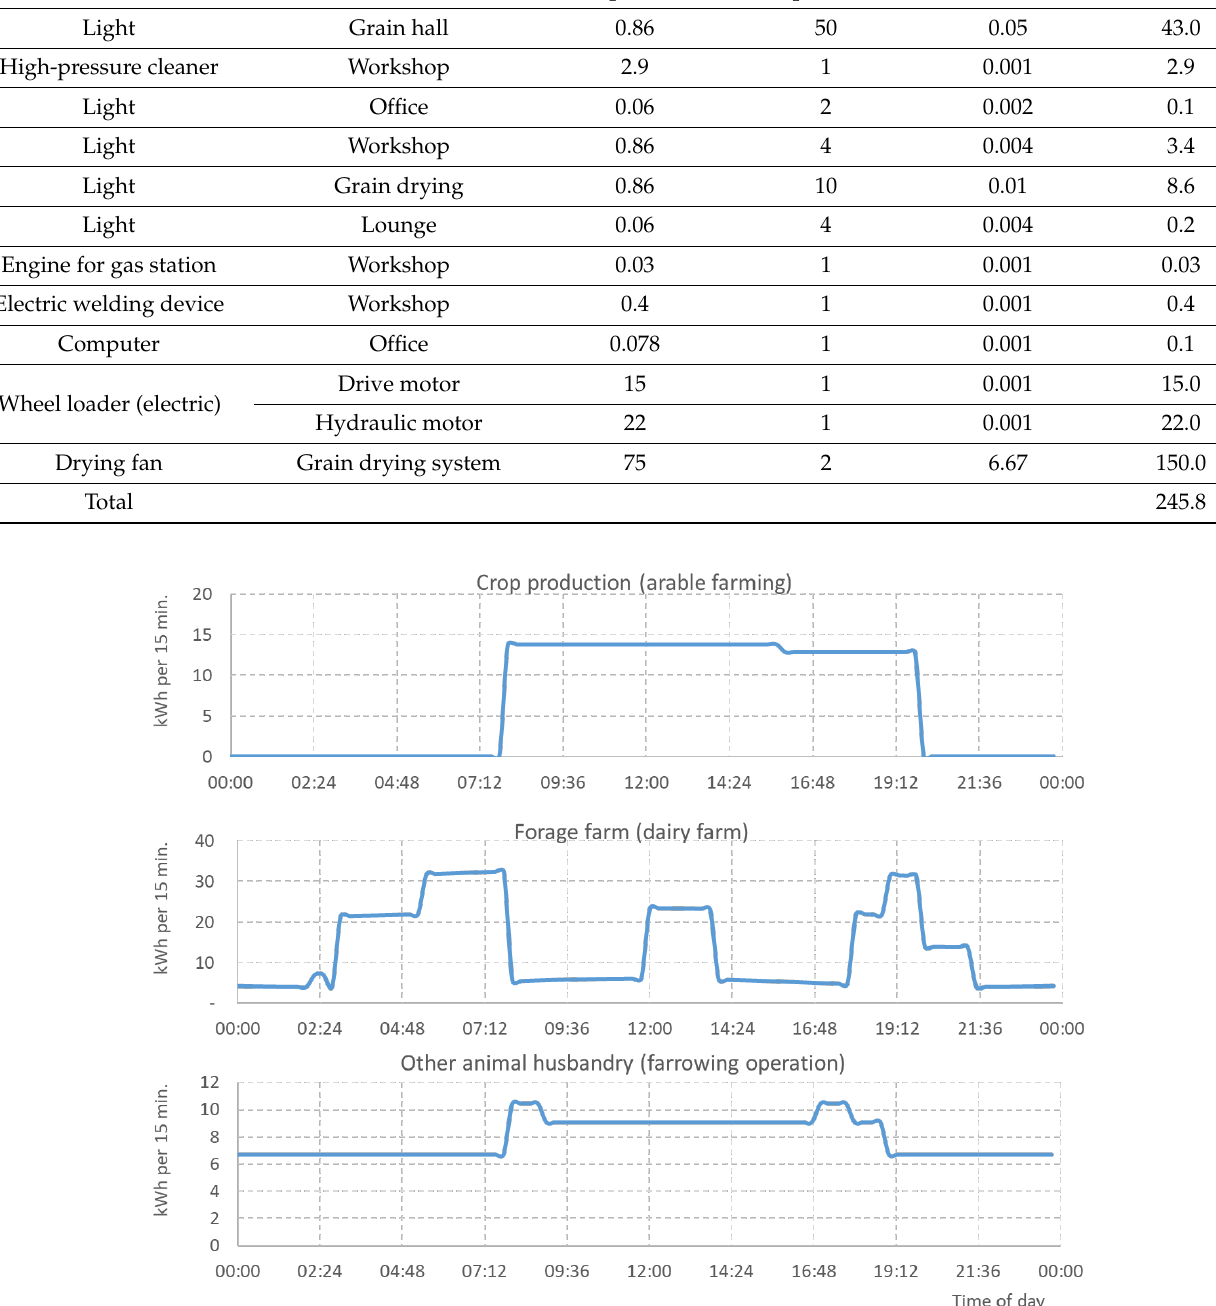
Figure 6. Typical load curves of various farm operations; continuous average daily electricity consumption in intervals of 15 min.